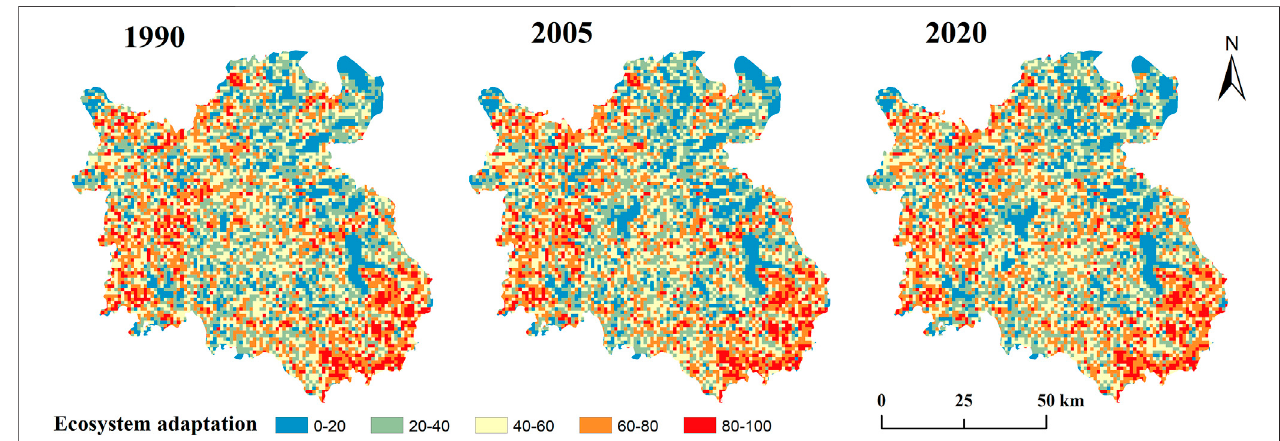
FIGURE 6 | Spatial distribution pattern of ecosystem adaptation in 1990, 2005, and